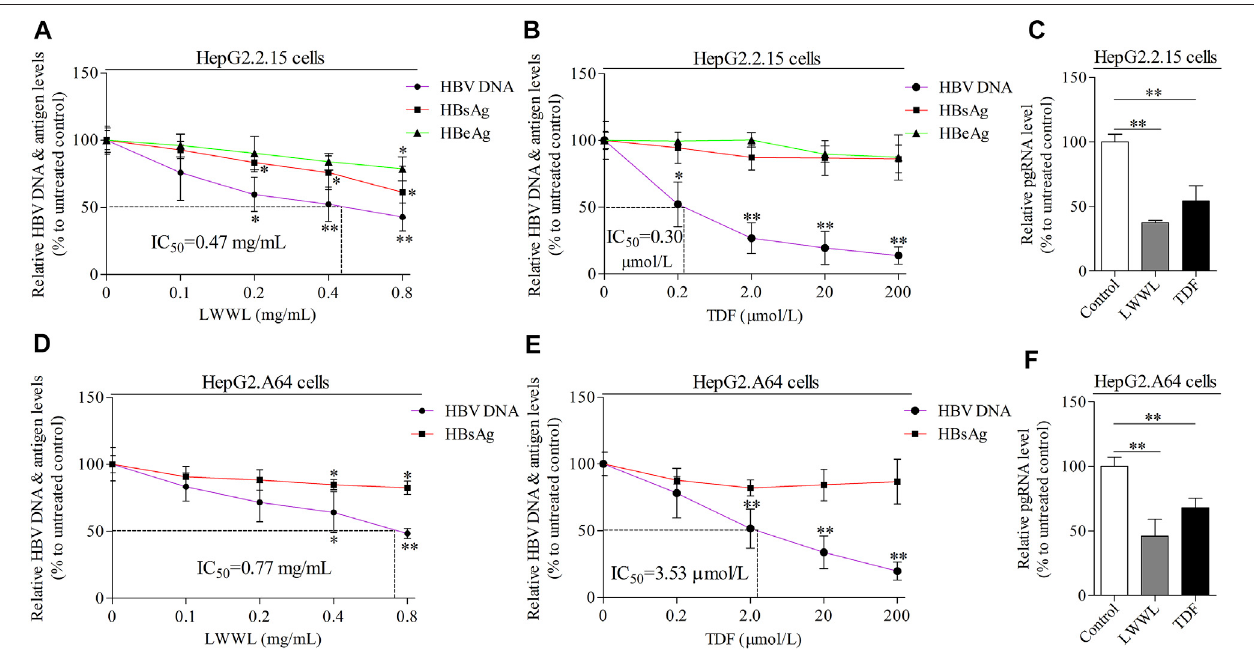
FIGURE 2 | The effects of LWWL on HBV DNA/RNA and antigen in cell models. The inhibitory effects of LWWL on HBV DNA and supernatant HBsAg ± HBeAg were tested for both (A) in HepG2.2.15 cells and (D) in HepG2. A64cells. The effects ofTDF against HBV were also tested in (B) HepG2.2.15 cells and (E) HepG2. A64 cells. TheeffectsofLWWLandTDFonsupernatantpgRNAwerealsotestedin (C) HepG2.2.15cellsand (F) HepG2.A64cells. Dashedlines indicateIC 50 ofLWWLand TDF.*and**represent p < 0.05and p < 0.01respectivelyindifferencecomparisonbetweenresultant values treatedwitheachindicatedconcentrationofLWWL(A, D) or TDF (B, E) and the value treated with zero concentration of LWWL or TDF. LWWL, Liuweiwuling Tablet; TDF, tenofovir disoproxil fumarate; pgRNA, pregenomic RNA; IC 50 , 50% maximal inhibitory